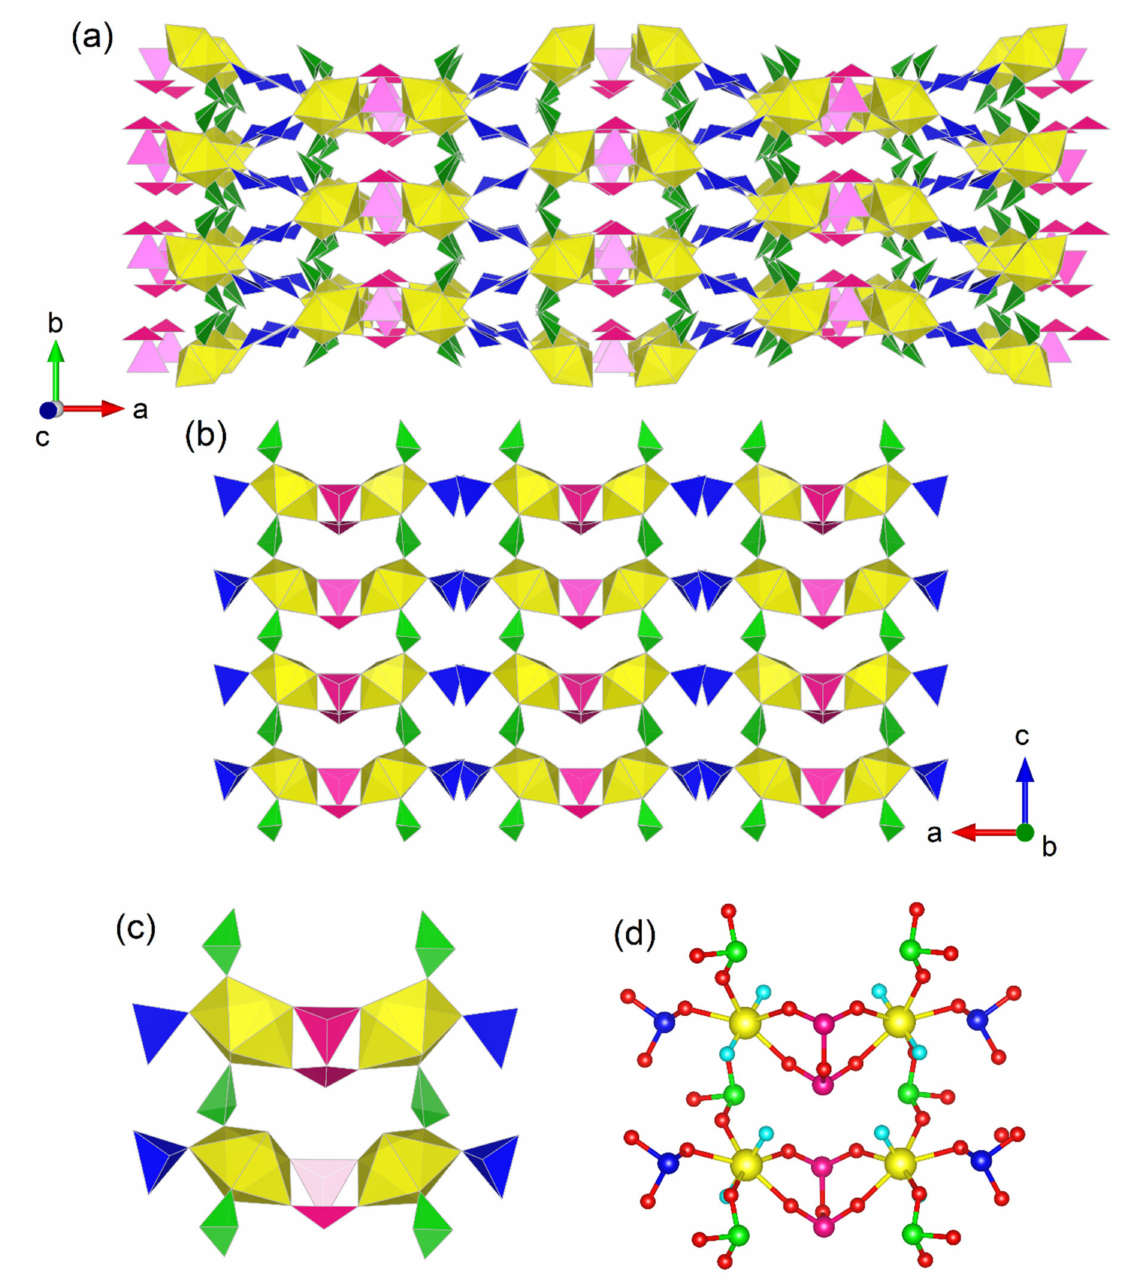
Figure 4. Structural representation of orthorhombic (UO 2 ) 2 (HSeO 3 ) 2 (H 2 SeO 3 ) 2 Se 2 O 5 in space group Cmc 2 1 ( a ) general representation, ( b ) in the [010] direction ( c ) highlighting the coordination motif of the [(UO 2 ) 2 (HSeO 3 ) 2 (H 2 SeO 3 ) 2 Se 2 O 5 ] 2 rings and ( d ) the bonding motif of the rings. Note yellow polyhedra, green polyhedra, blue polyhedra, pink polyhedra, yellow spheres, red spheres, aqua blue spheres, green spheres, blue spheres and pink spheres respectively represent UO 7 , HSeO 3 , H 2 SeO 3 , Se 2 O 5 , U, O, uranyl O, Se in HSeO 3 , Se in H 2 SeO 3 and Se in Se 2 O 5 units/atoms